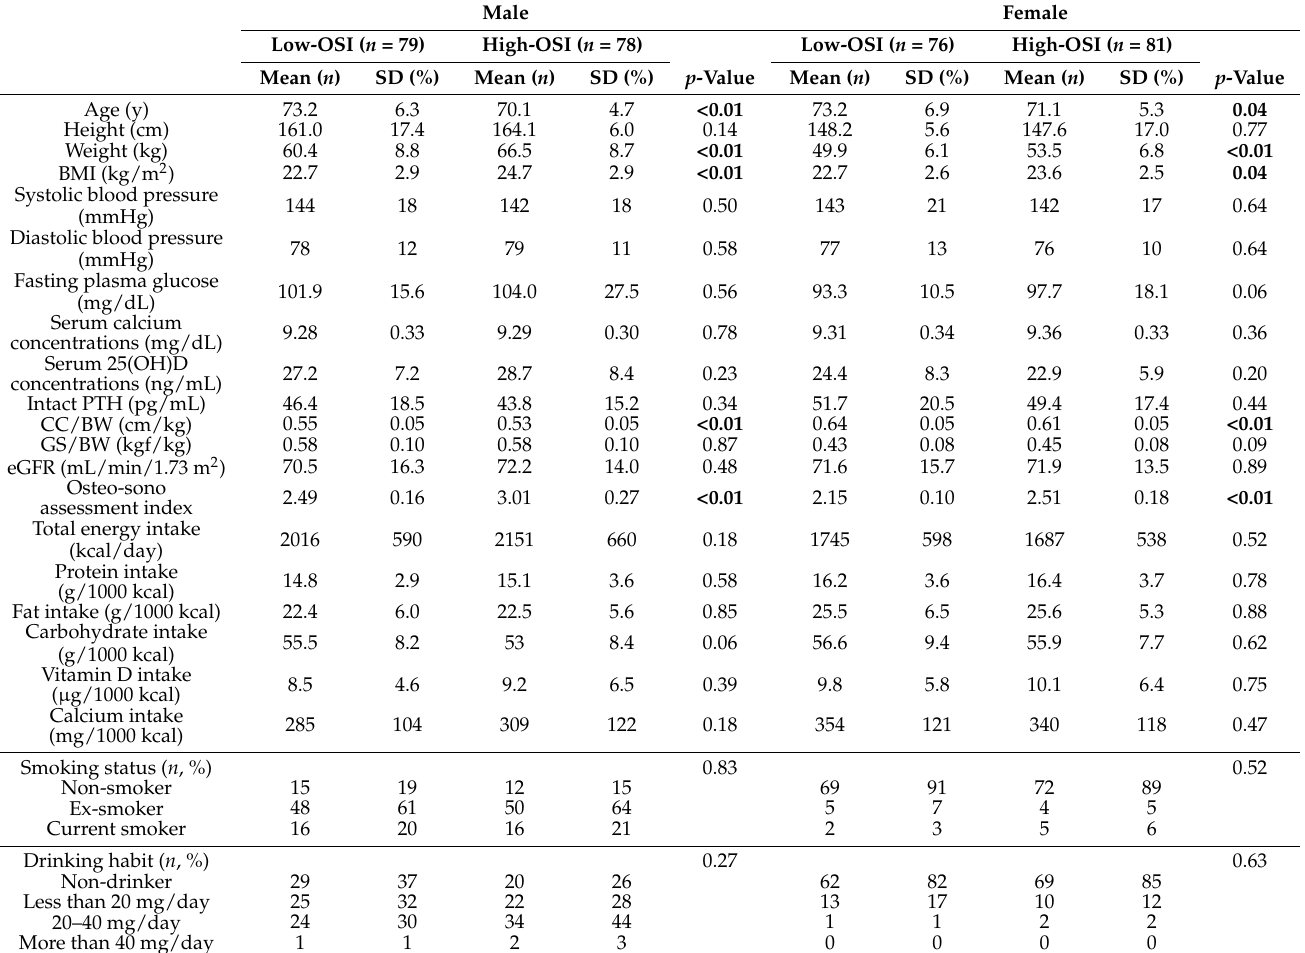
Table 2. Comparison of characteristics between low- and high OSI groups according to